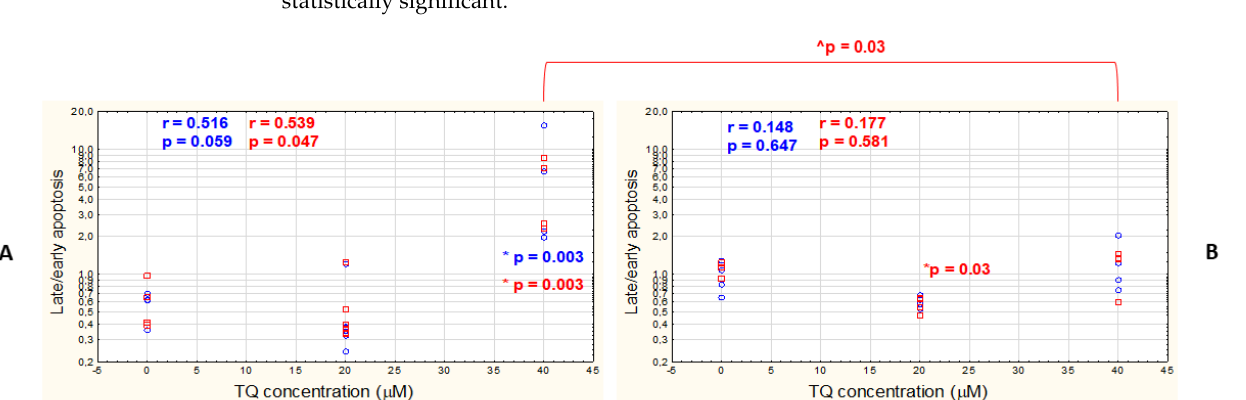
Figure 2. A375 cells showed higher sensitivity to 40 µ M TQ compared to staurosporine. Cytometric analysis of apoptosis in A375 ( A ) and WM9 ( B ) cells, treated with 40 µ M TQ, or 1 µ M staurosporine, for 48 h. * denotes a significant increase in the percentage of apoptotic cells compared to staurosporine control (Mann–Whitney U test); data are presented as mean ± SD; * p < 0.05 was considered to be statistically significant.